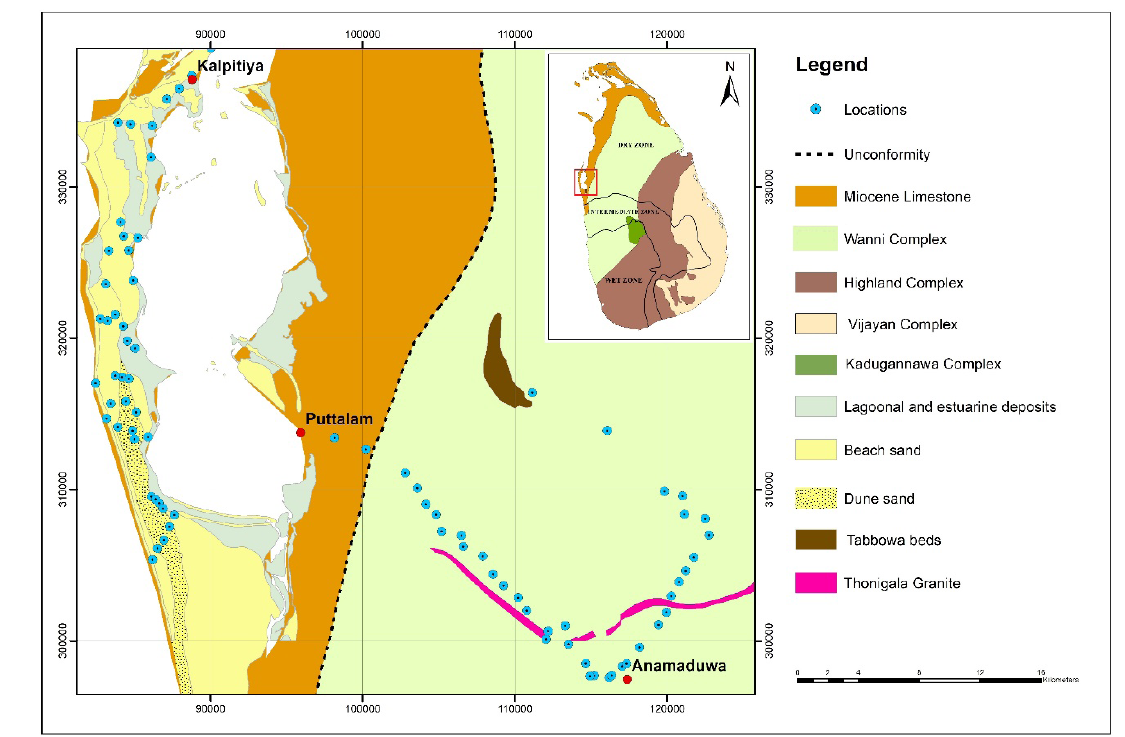
Figure 1: Study area including geological formations and sampling locations. The inset showing the major lithologic units and climatic boundaries from wet, intermediate to dry zones in Sri Lanka (Modified after GSMB Geological Map,